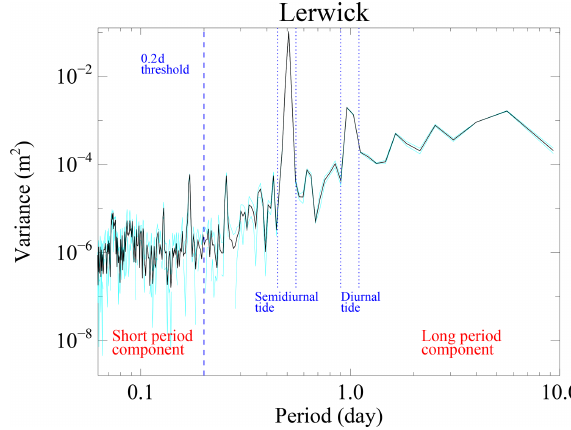
Figure 3. Sample spectrum of a 14d time series of water level for Lerwick. The 0.2d threshold separating the short period and long period components of the time series reconstructions is shown, as well as the thresholds defining the diurnal and semidiurnal compo- nents that were used to de-tide the time series. The uncertainty in the spectrum (light blue line) is calculated as the standard deviation of three spectra derived from re-sampling the time series at every third